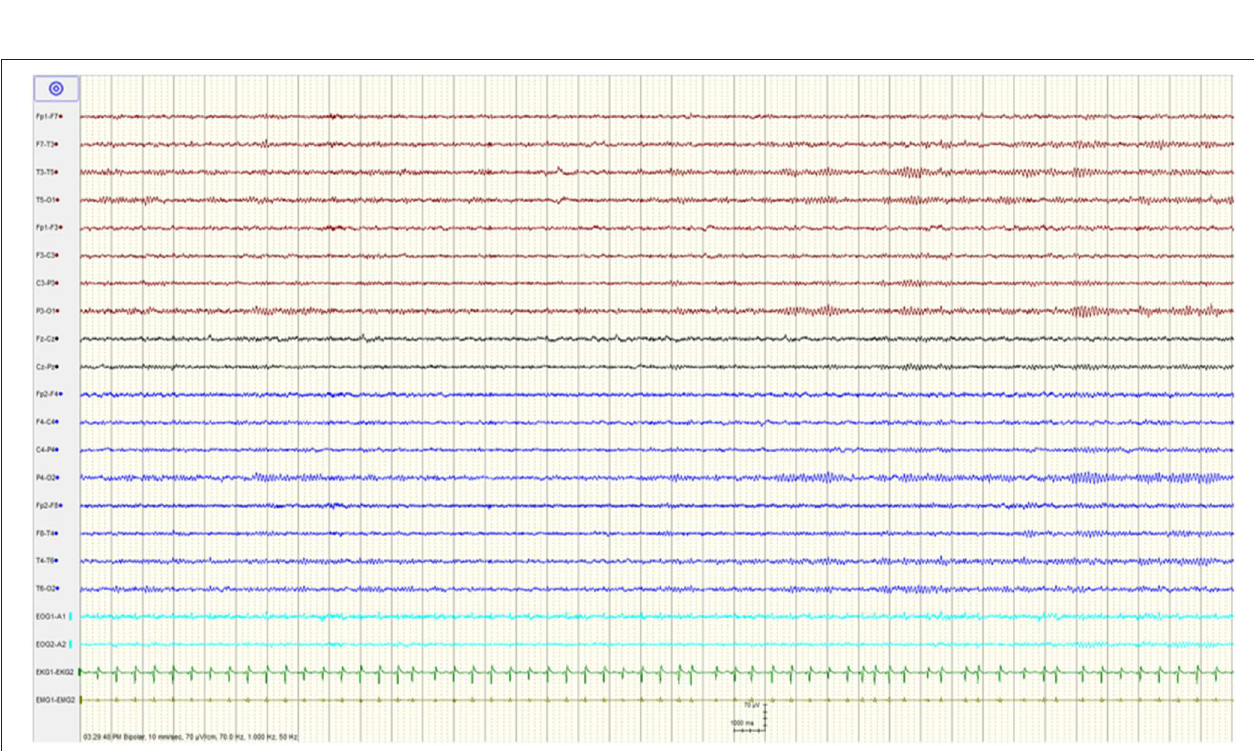
Frontiers in Neurology | www.frontiersin.org